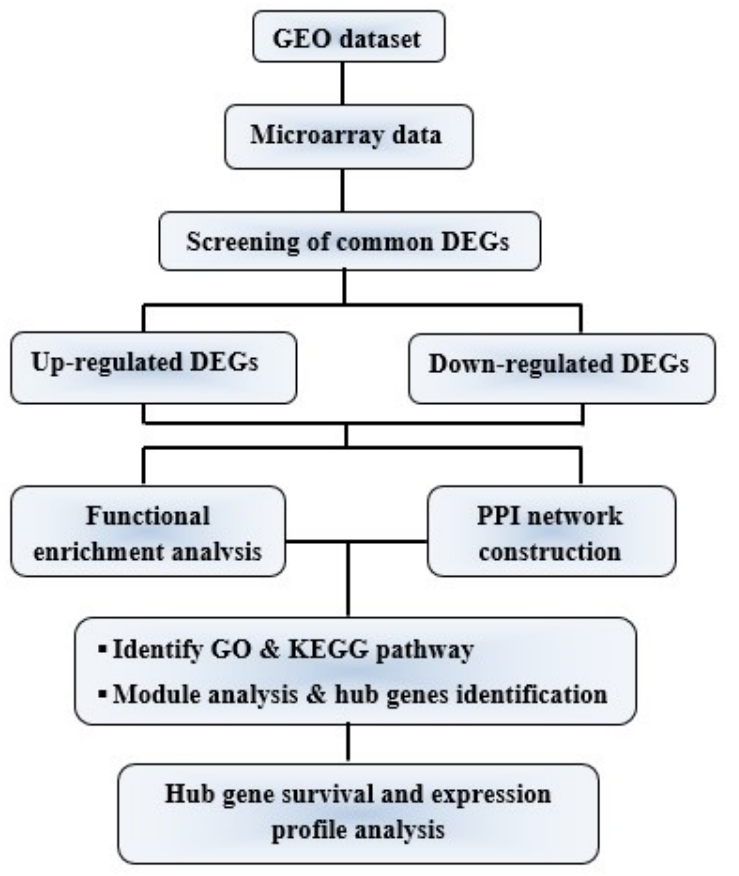
Figure 1. Flow diagram of integrative bioinformatics analytical approach applied in this study.